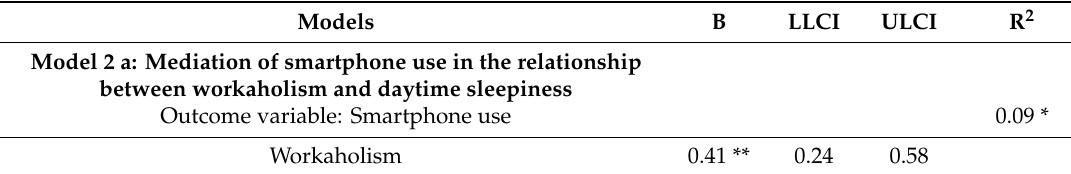
Table 3. Model 2—Results of the direct and indirect e ff